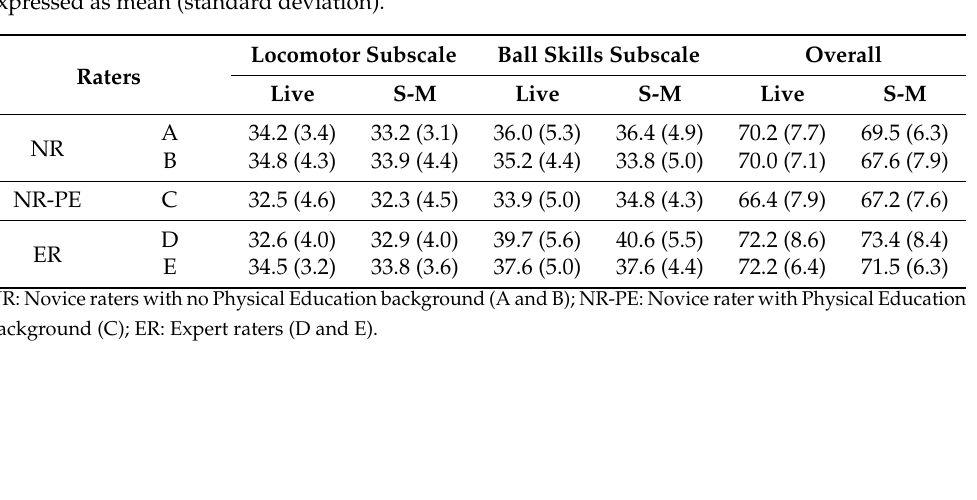
Table 2. Descriptive statistics of overall score and locomotor and ball skills subscales’ scores. Results expressed as mean (standard